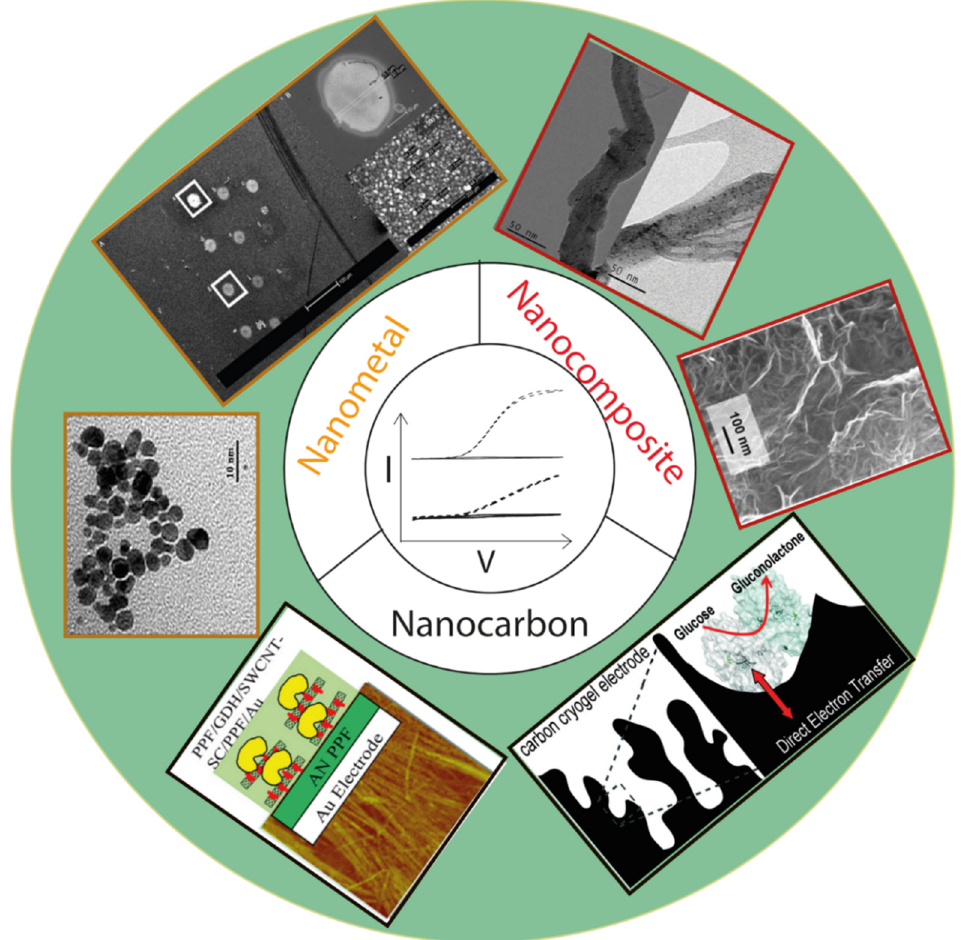
Figure 17. Overview of the examples of commonly employed nanomaterials for enabling or enhancing DET electrocatalysis. Nanocarbon: carbon cryogel for PQQ-glucose dehydrogenase [50], SWCNT for FAD-glucose dehydrogenase [144]; nanometal: polyethyleneimine-stabilized Au nanoparticles for cellobiose dehydrogenase [153], mixed thiol-SAMs modified Au nanoparticles for cellobiose dehydrogenase [127]; nanocomposites: PtNPs-MWCNT and PdNPs-MWCNT for cellobiose dehydrogenase [154], CNT-supported reduced graphene oxide for horseradish peroxidase [151]. Table 3. Nanomaterials, modifications, and performance of DET enzymes.